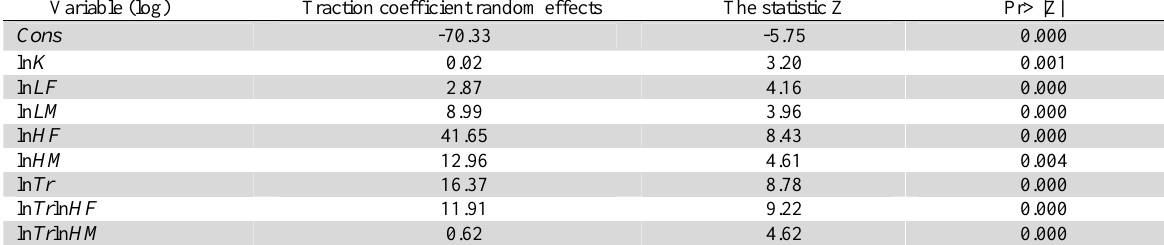
The results of estimating equation (12) for OECD countries using the random effects